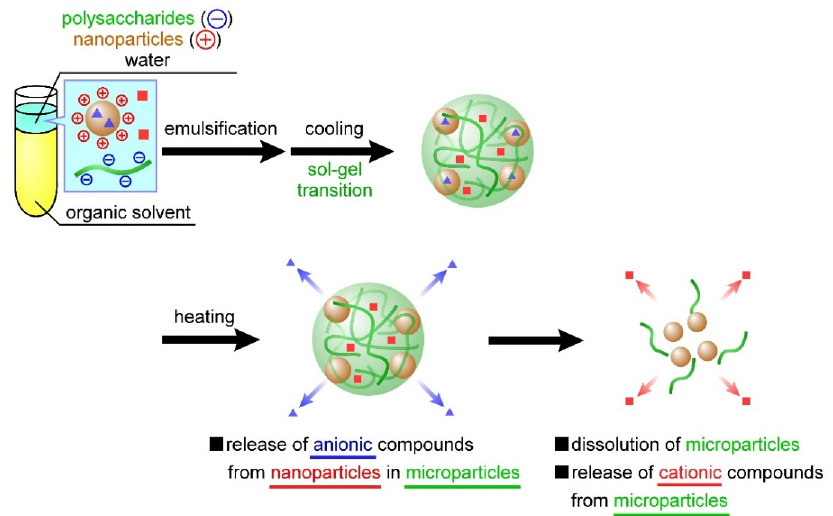
Figure 8. Release behavior of temperature-responsive nanoparticle-containing polysaccharide mi- croparticles based on the experimental results of this study.